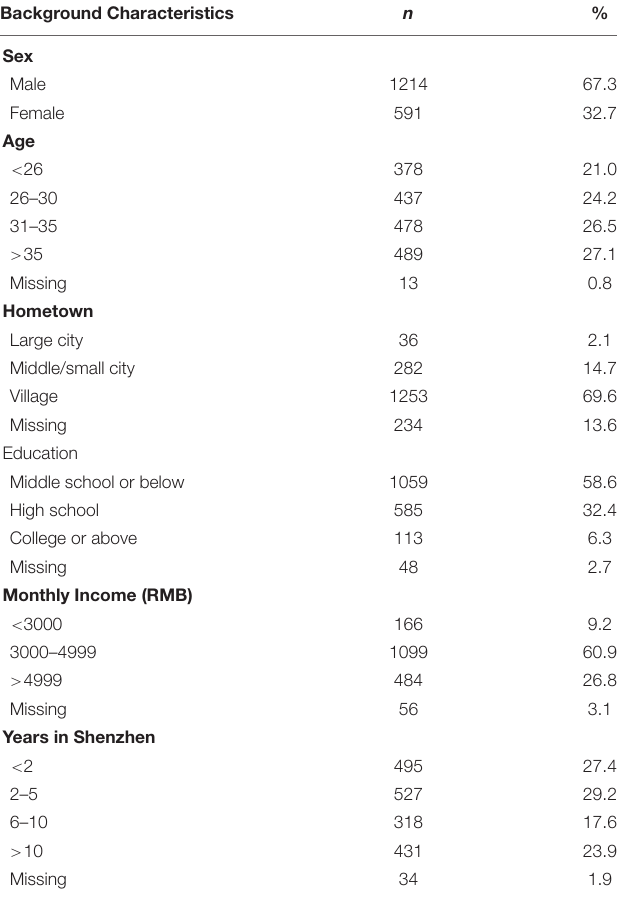
TABLE 1 | Background characteristics of the participants ( N =